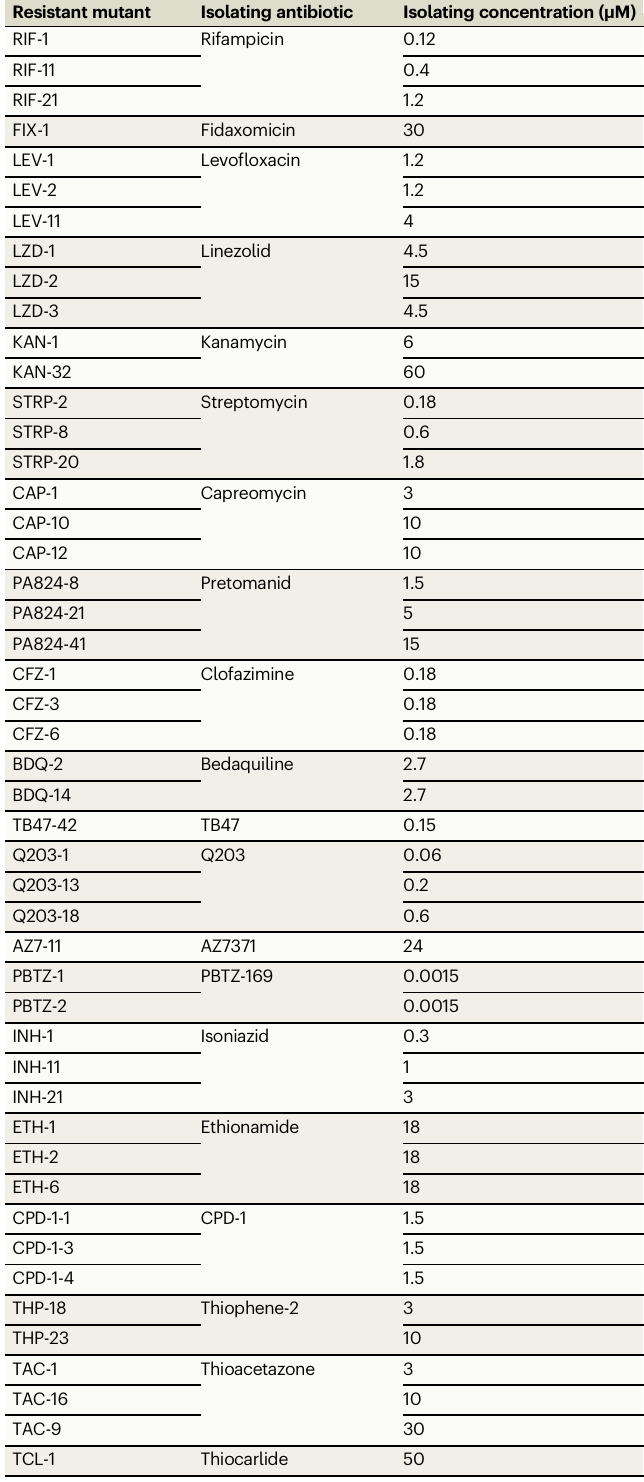
Table 2 | Drug-resistant M. tuberculosis mc 2 6206 strains generated and used in this study Resistant